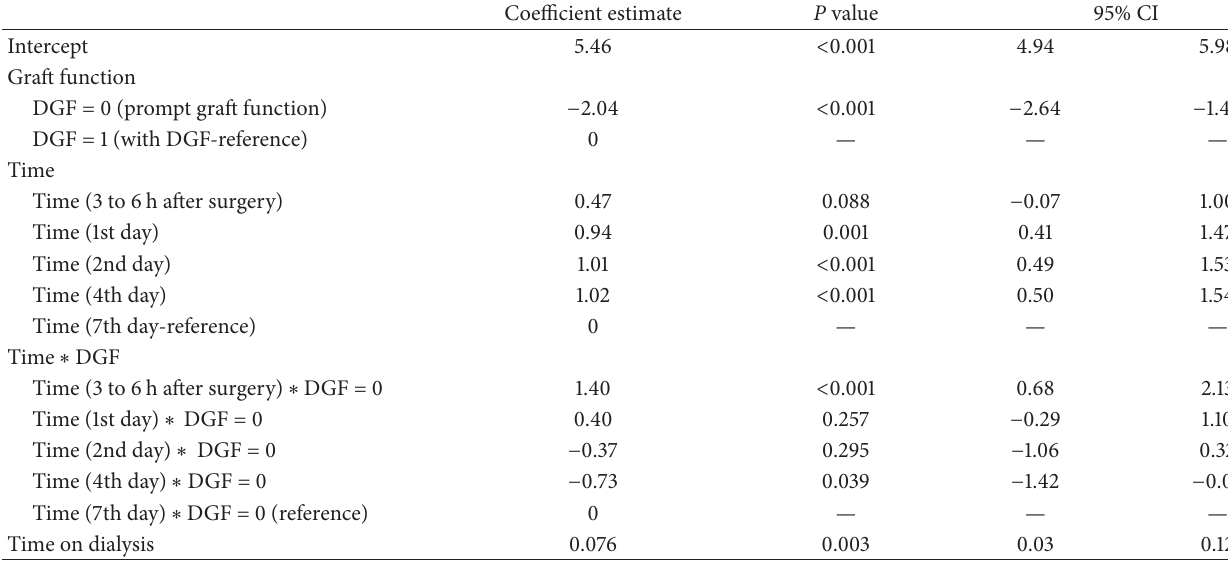
Table 3: Results of the final linear mixed model for dependent variable ln(uNGAL) ( 𝑛 = 171 observations derived from 40 patients).